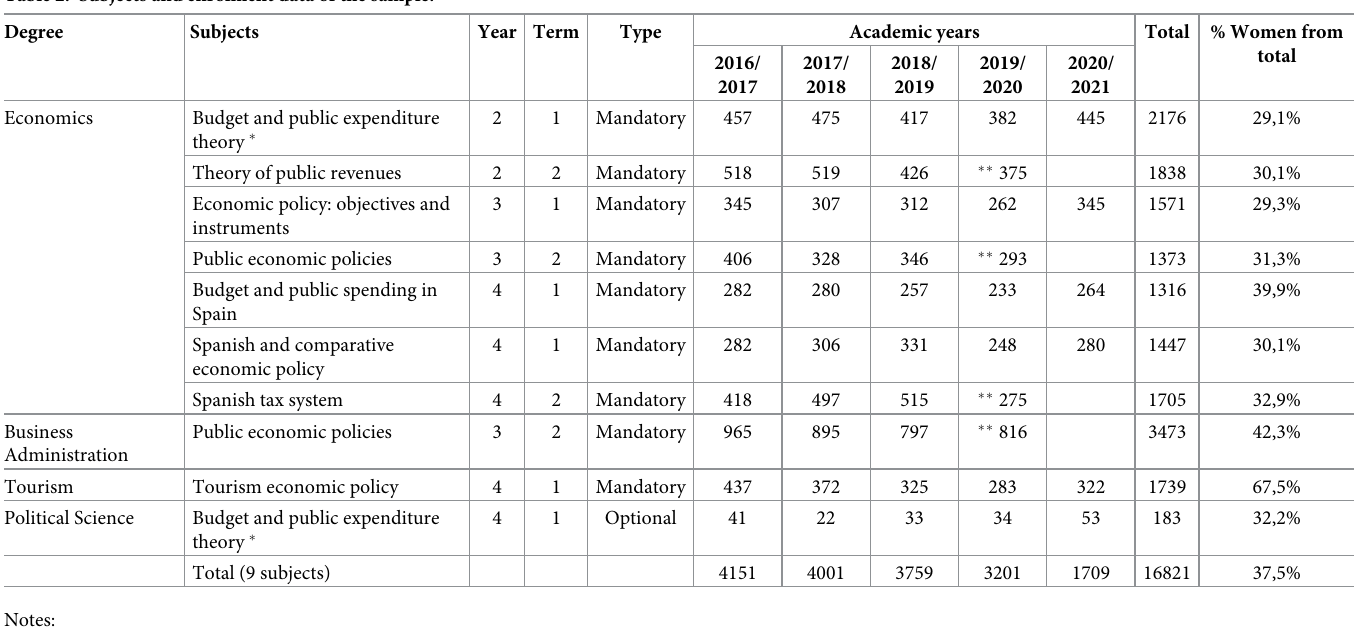
Table 2. Subjects and enrolment data of the